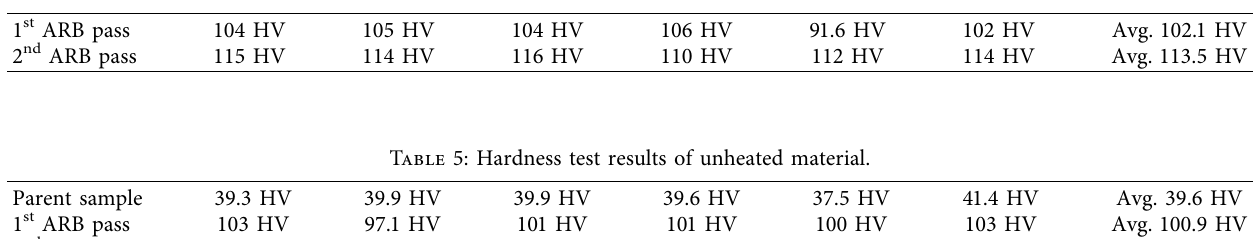
Table 4: Hardness test results of heated material.